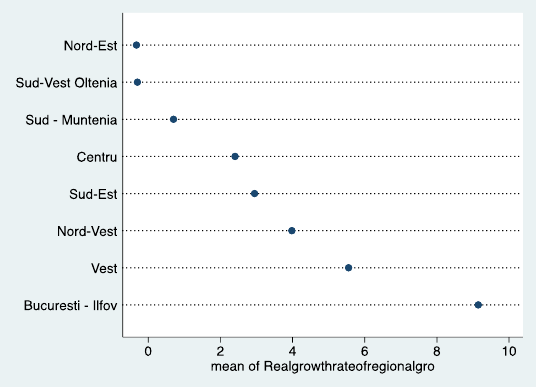
Figure 7. Real growth rate of regional gross value added (GVA) at basic prices. Source: computed by the authors based on the Eurostat database [23] using Stata 15.1.